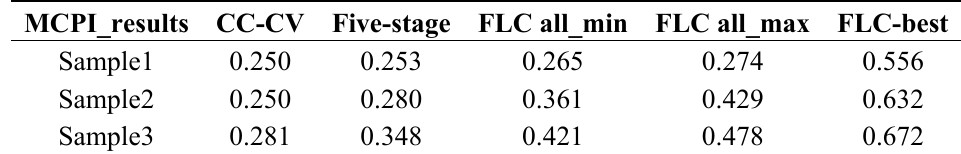
Table 11. Obtained MCPI results of five tested